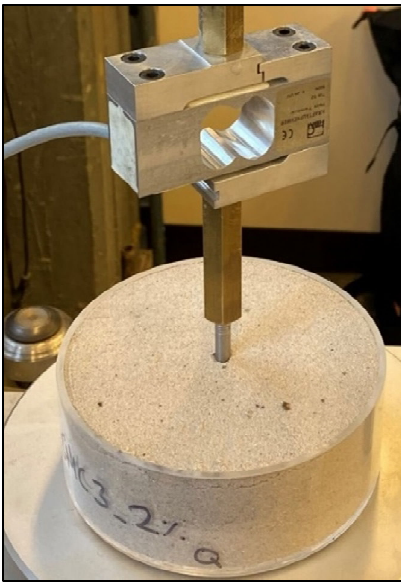
Figure 3. Penetrometer testing of fine-grained silica sand sample.